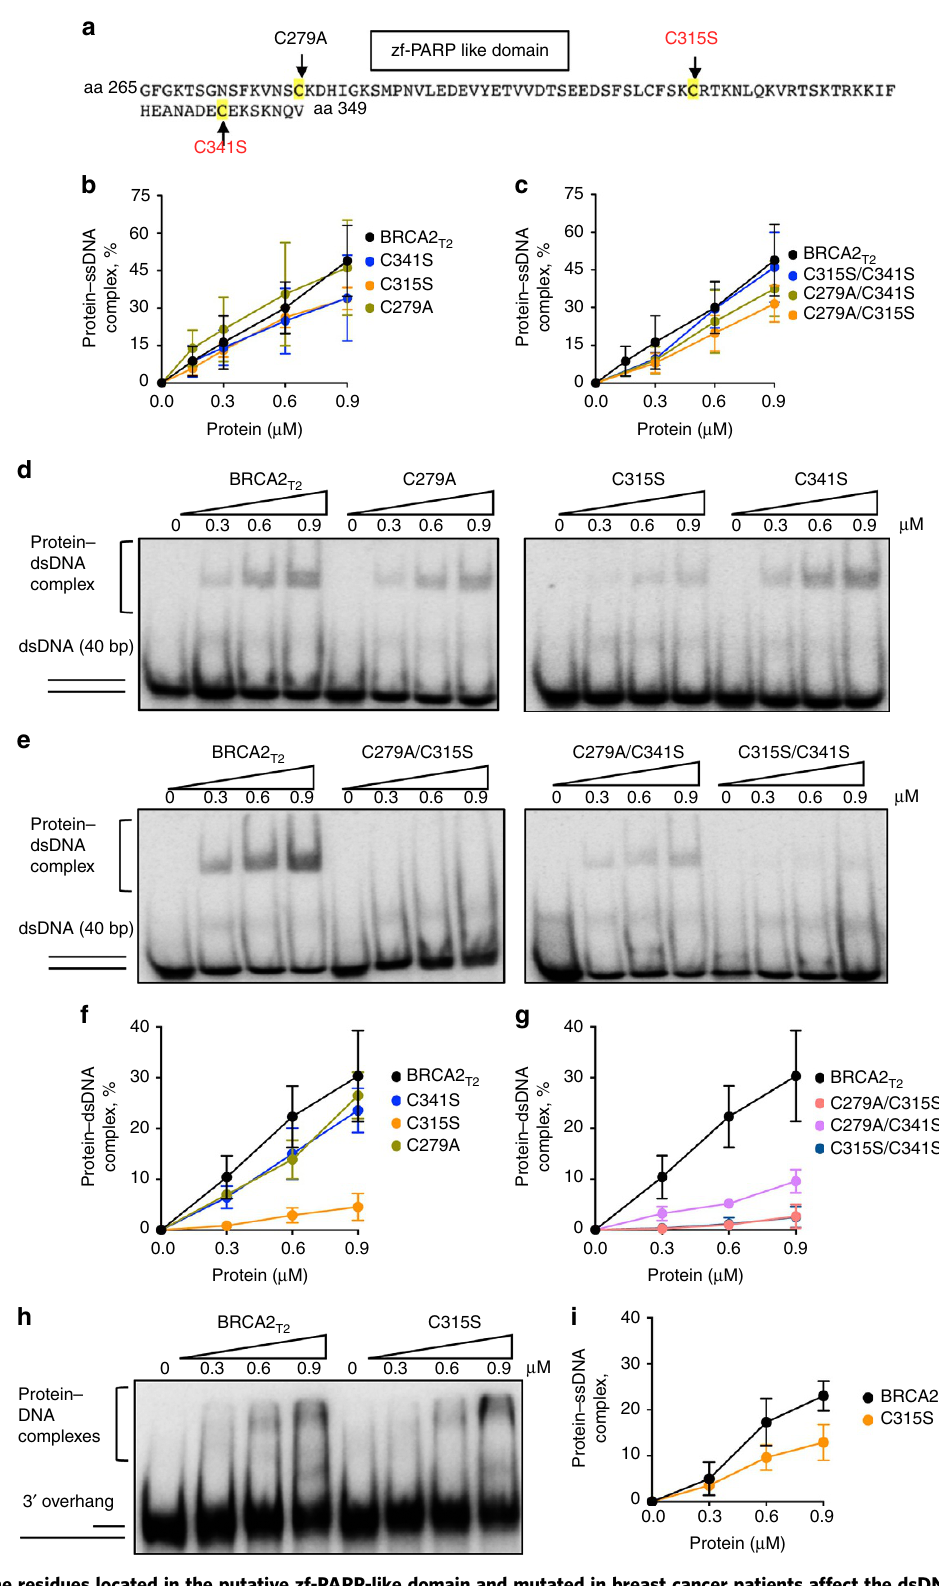
Figure 3 | Cysteine residues located in the putative zf-PARP-like domain and mutated in breast cancer patients affect the dsDNA binding activity of BRCA2 T2 . ( a ) amino-acid sequence comprised in the putative zf-PARP-like domain defined by SMART showing the mutated cysteine residues. The ones found in breast cancer patients are highlighted in red. ( b ) Quantification of EMSA displayed in Supplementary Fig. 5b, ( c ) showing the binding of BRCA2 T2 , the indicated single mutants ( c ), and the double mutants to ssDNA. ( d ) EMSA showing the binding of BRCA2 T2 and the indicated single mutants ( e ), and the double mutants to dsDNA. ( f ) Quantification of d . ( g ) Quantification of e . ( h ) EMSA showing the binding of BRCA2 T2 and BRCA2 C315S to 3’ overhang ssDNA. ( i ) Quantification of h . Error bars, s.d. ( n ¼ 3). NATURE COMMUNICATIONS|7:12813|DOI: